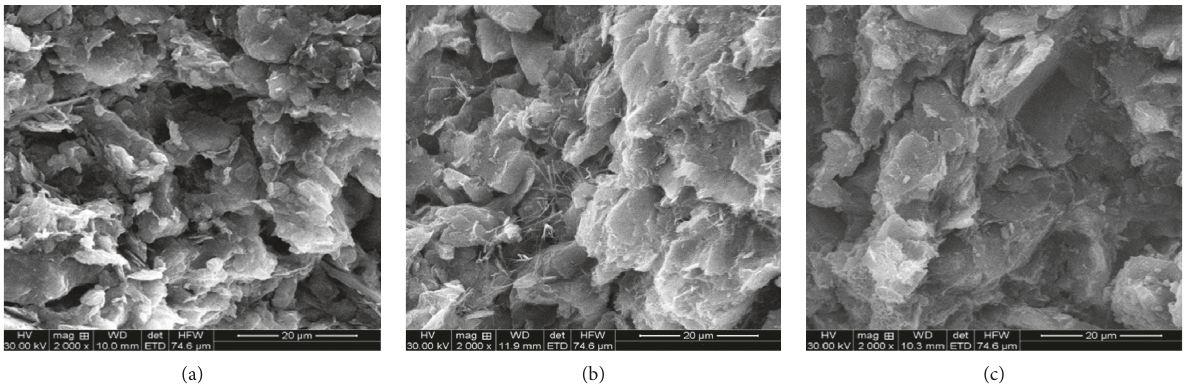
Figure 9: Scanning electron microscope observations of the solidified/stabilized soils. (a) 0. (b) OPC-20%. (c)